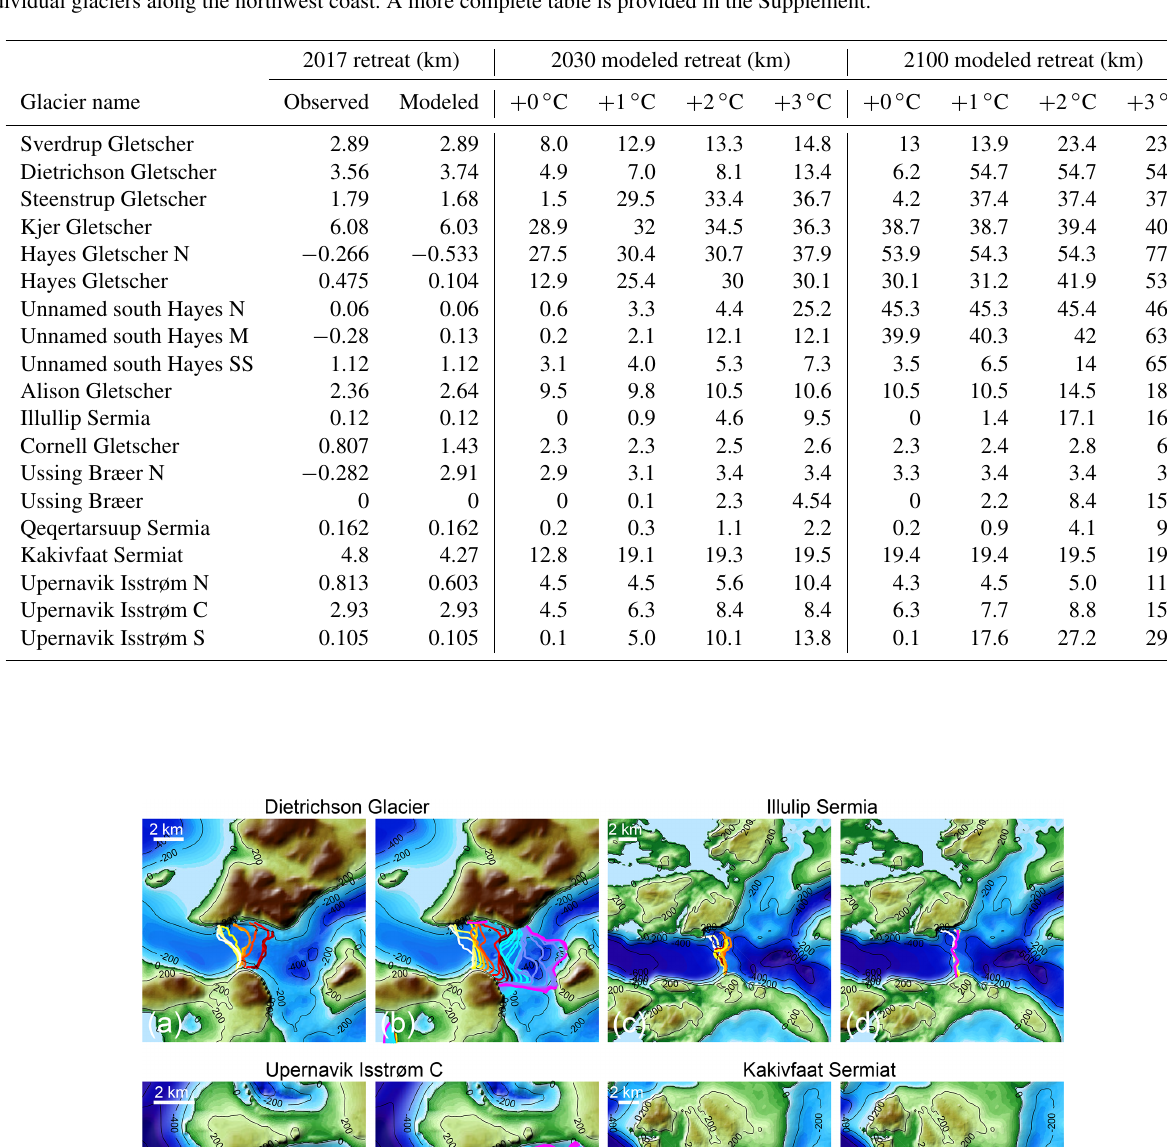
Table 1. Observed and modeled ice front retreat (in km along a centerline) between 2007 and 2017 under current forcing (first two columns) and modeled retreat between 2007 and 2030 and between 2007 and 2100, under different scenarios of ocean forcing with today’s q sg for individual glaciers along the northwest coast. A more complete table is provided in the Supplement.